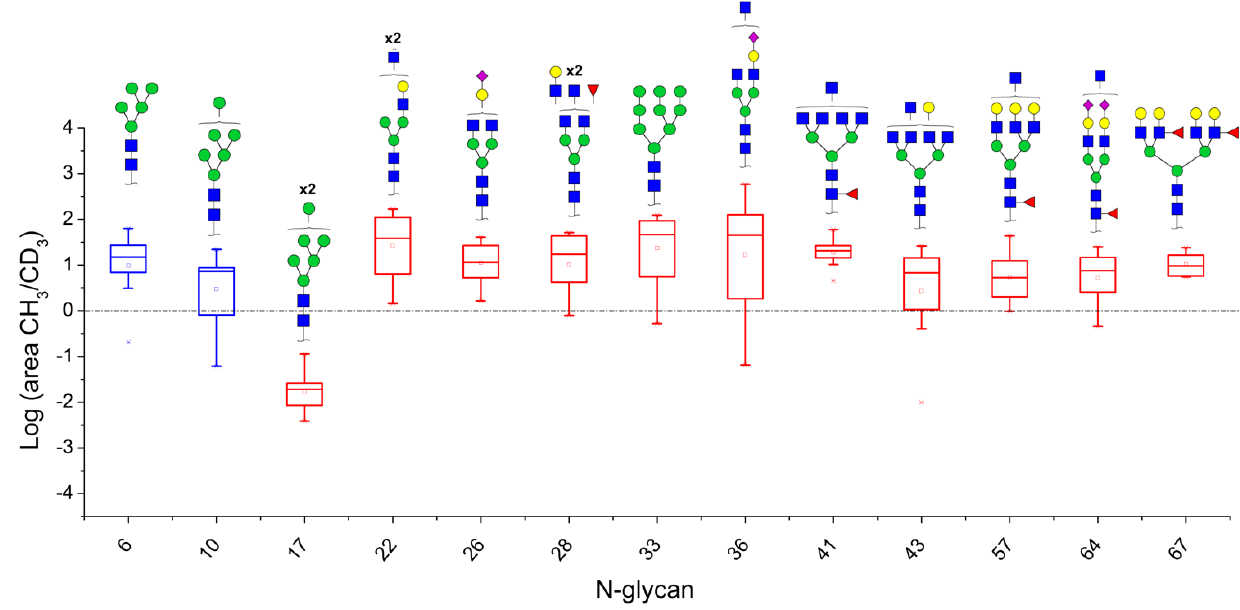
Figure 3. Box plots showing relative abundance of up- and down-regulated N-glycans isolated from blood serum of cancer patients and control patients (Mann–Whitney U test, α = 0.01) analyzed by ( A ) MALDI-TOF/MS and ( B ) LC-MS/MS. The lower and upper whiskers represent the 5th and 95th percentile, respectively, while the median is represented as a straight line, the mean by an open box ( ⎕ ), and data outliers are represented by the X symbol.